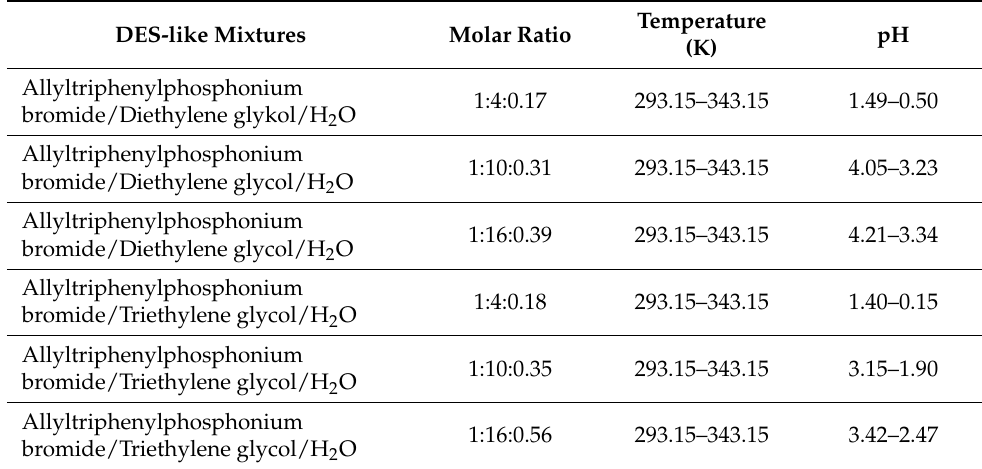
Table 12. Molar ratios, water contents, and pH values of DES-like mixtures in (adapted according to Ghaedi et al.) [49].